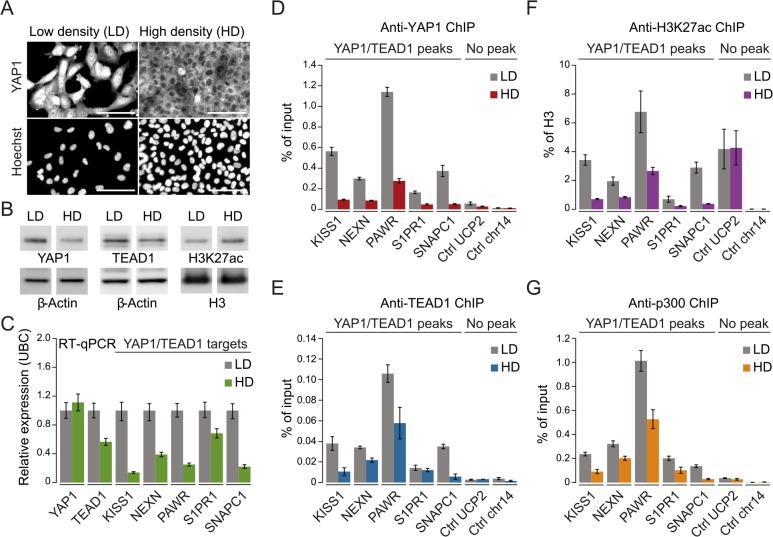
YAP1 mediates active enhancer chromatin and expression of target genes.(A) YAP1 immunofluorescence staining in SF268 cells grown at low (LD) or high density (HD). The corresponding DNA Hoechst 33342 staining is shown. Scale bar = 100μm. (B) Western blot analysis of YAP1, TEAD1 and H3K27ac from LD and HD SF268 cells. β-Actin and histone H3 served as loading controls. (C) mRNA expression of YAP1, TEAD1, KISS1, NEXN, PAWR, S1PR1, and SNAPC1 from cells cultured at LD or HD (normalized to Ubiquitin C (UBC)). Data are representative of at least three independent experiments. Error bars indicate the standard deviation of triplicate qPCR data.(D, E, F and G) Analysis of (D) YAP1, (E) TEAD1, (F) H3K27ac, and (G) p300 occupancy at YAP1/TEAD1 peak regions from cells cultured at LD or HD by ChIP-qPCR. Data are representative of at least three independent experiments. Error bars indicate the standard deviation of triplicate qPCR data.